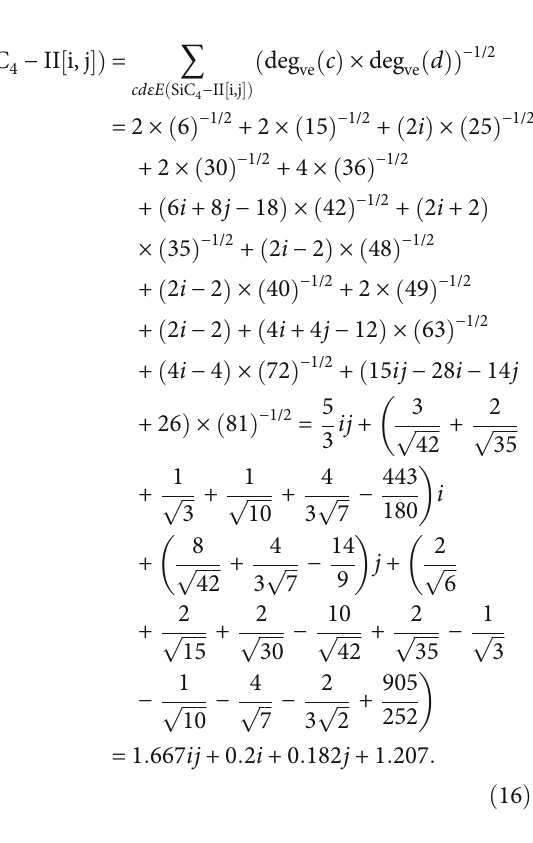
Table 8: Numerical calculations of TIs for SiC